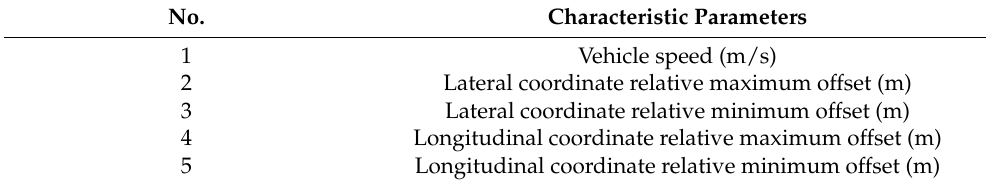
Table 1. Characteristic parameter